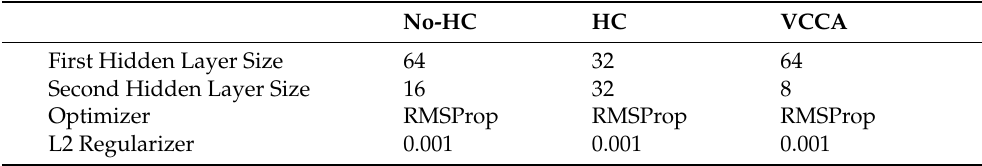
Table 4. The hyperparameters used for Dataset 1.